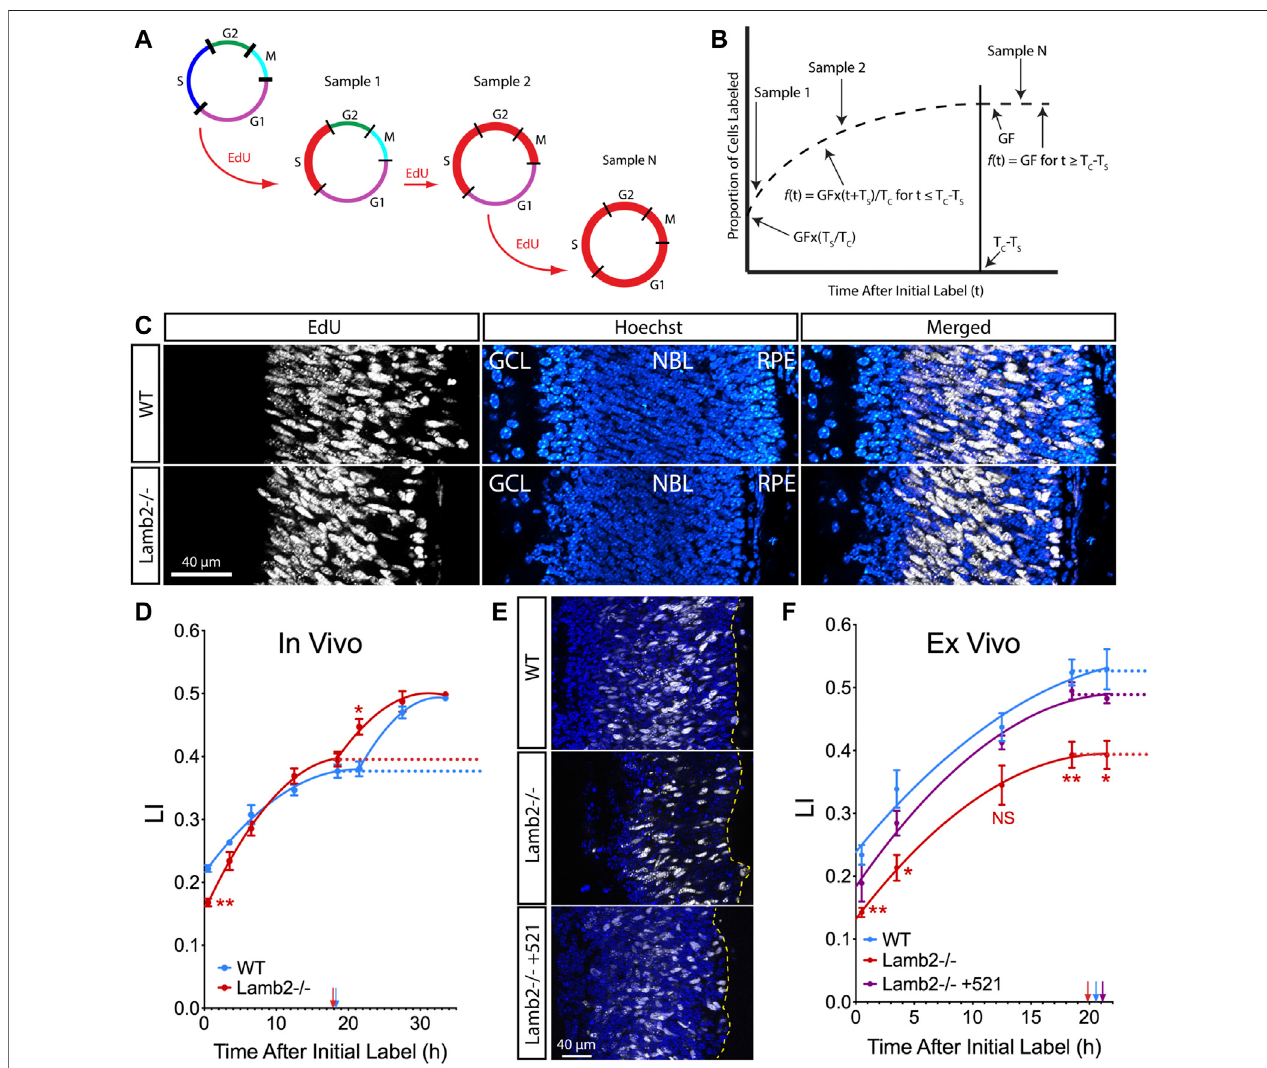
FIGURE 1 | RPC T C and T S are laminin-dependent. (A) . Model illustrating the principle of cumulative S-phase labeling. This method relies on continuous EdU exposure,labelingsuccessivepopulationsofcellsenteringtheS-phase.RedlinemarksthedistributionofEdU-labeledcellswithinthecellcycle. (B) .Modelillustratingthe quanti fi cation of the results of cumulative EdU labeling. The proportion of EdU+ cells within the NBL was measured and plotted vs. the time off EdU exposure. A sharp initial rise in the labeling index re fl ects entry of unlabeled cells into the S-phase. This is followed by a plateau, which indicates the time when the entire proliferating populationhasbeenlabeled.Growthfraction(GF)ismeasuredastheratioofEdU+cellstototalcellnumberintheNBL.T C – timeofcellcycle.T S – timeoftheS-phase. (C) . Representative images of cross-sections of P3 retina that had been continuously labeled for 27.5 h. (D) . EdU saturation curves resulting from cumulative EdU labeling experiments in P3 retinas. (E) . Representative images of cross-sections of retinal explants that had been continuously labeled for 21.5 h. (F) . EdU saturation curves resulting from cumulative EdU labeling experiments performed on retinal explants. Dotted lines designate the GF at plateaus in the curves. Arrows indicate time when labeling index reached the plateau (T C -T S